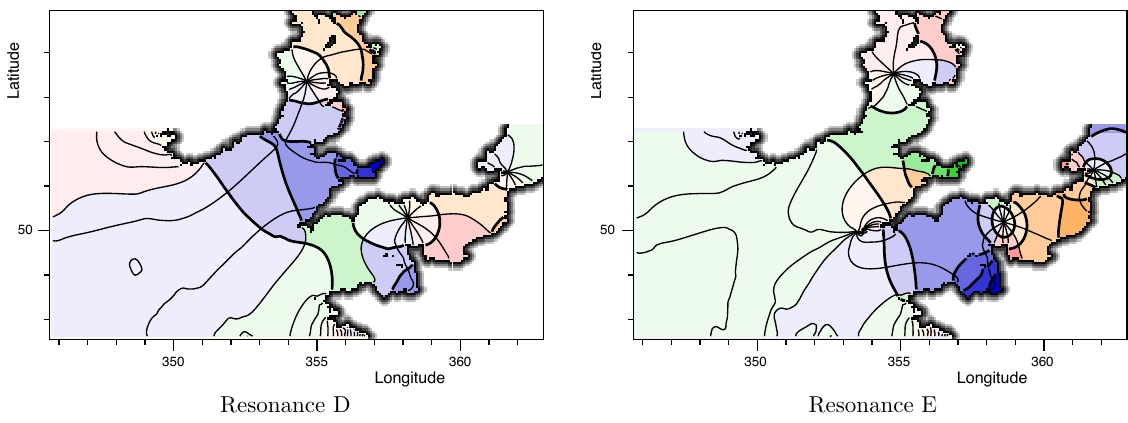
Fig. 8. Amplitude and phase of the resonances D and E (Table 3). The resonance is normalized such that its maximum amplitude is 1 . 0. Colours denote phase (red, 0–90 ◦ ; brown, 90–180 ◦ ; green, 1800–270 ◦ ; blue, 270–360 ◦ ) with additional thin contours plotted at intervals of 30 ◦ . Colour intensity denotes amplitude. The lightest colours, seen near the shelf edge and beyond, denote amplitudes less than 1% of the maximum. The remaining bands separated by thick contours denote 1–20%, 20–40%, 40–60%, 60–80% and 80–100% of the